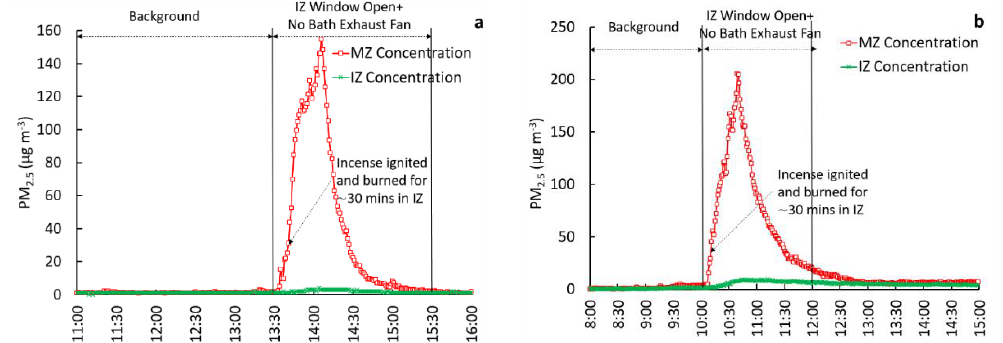
Figure 3. Comparison of PM 2.5 concentrations in the IZ and MZ under one IZ window open, exhaust ventilation off scenario (Test 3) with trial 1 on the left ( a ) and trial 2 on the right ( b ). a : explanation; b : explanation.